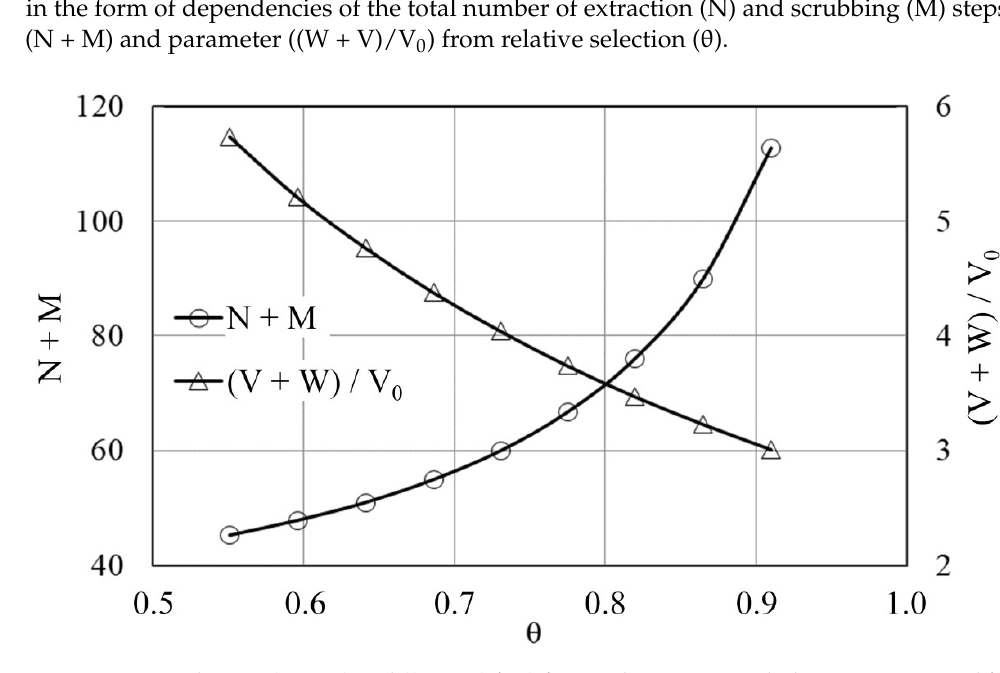
Figure 1. Dependencies (N + M) and ((V + W)/V 0 ) from value θ at SE with the mixture 0.4 mol/L TOMANO 3 -1.6 mol/L TBP in